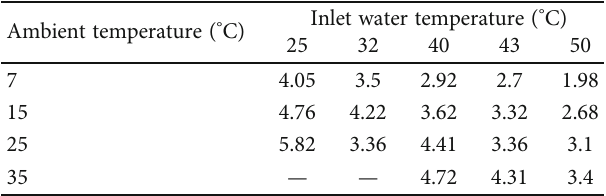
Figure 3: Veri fi cation result of the PV/T experimental and the simulation results. Table 1: COP of the heat pump as a function of ambient and hot water